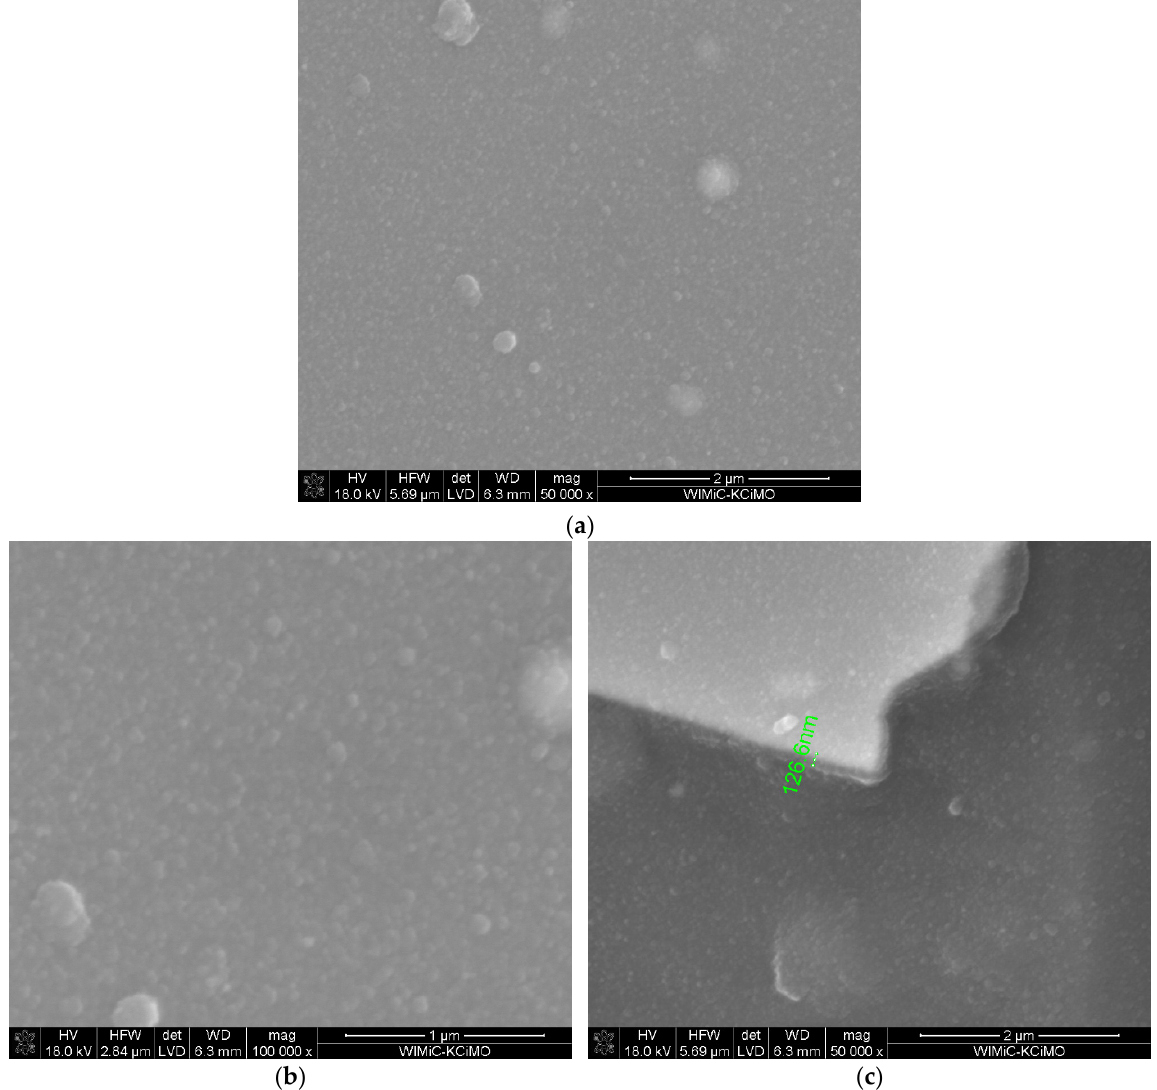
Figure 6. Microstructure of the layer synthesised at temperature of 700 °C on tubular substrate at different magnifications: 50,000× ( a) and 100,000× ( b ) and the cross-section: the layer–the substrate ( c ). The content of Sc(tmhd) 3 in the gas mixture: 14 mol.%. Total gas pressure: 6580 Pa. Deposition time: 10 min. tent in this layer was 8.16 mol.%.